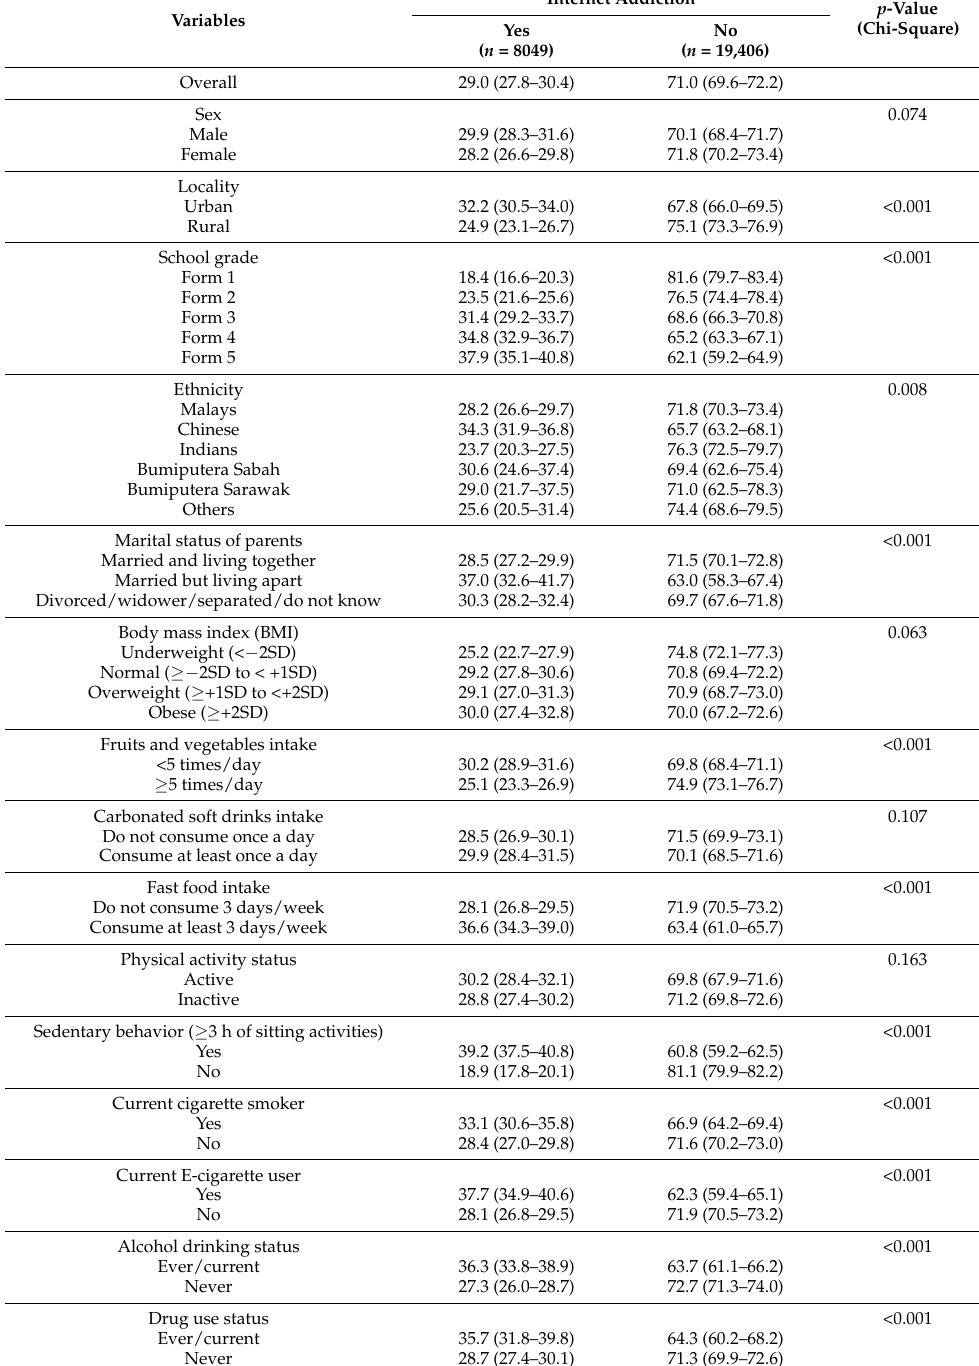
Table 2. Prevalence of internet addiction (% (95% CI)) among Malaysian adolescents ( n = 27,455) by demographic and lifestyle